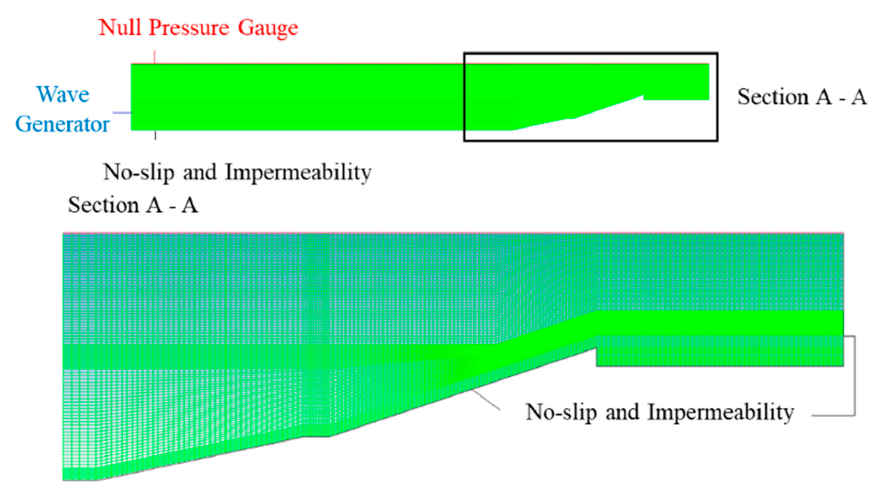
Figure 4. Spatial discretization of overtopping device detailing the regions of ramp and obstacle.